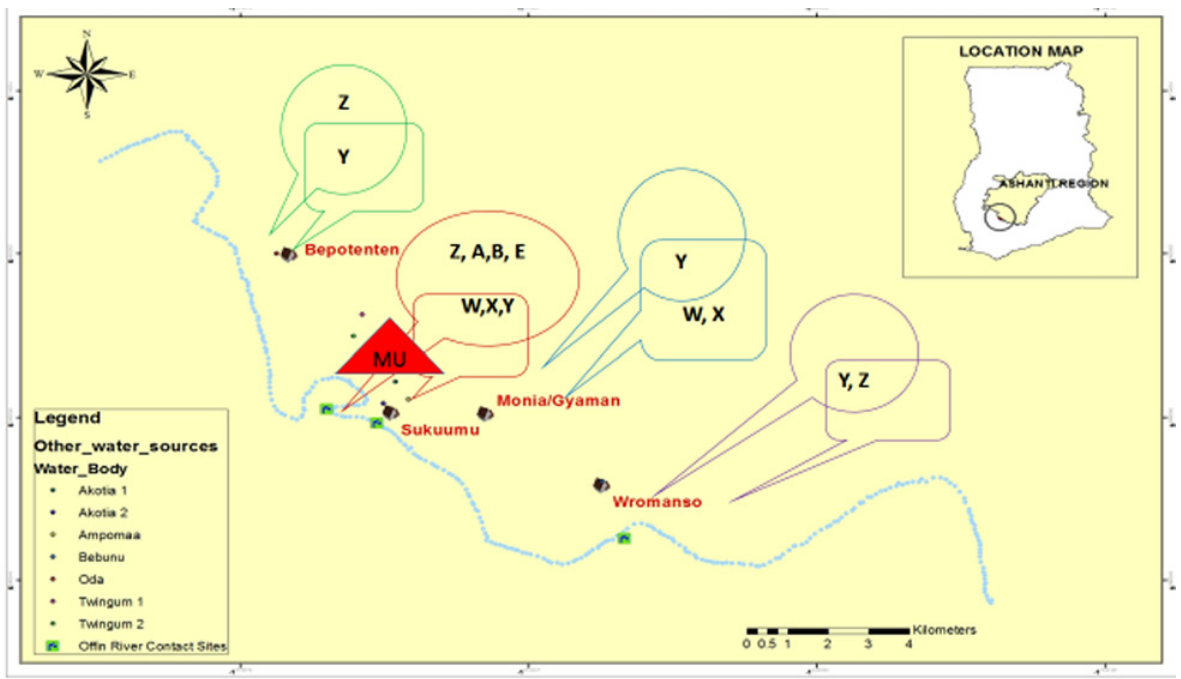
Figure 4. Community-based geographical distribution of MPM genotypes from humans and water bodies. The map of study communities was drawn using ArcMap 10. Rectangular and circular callouts contain genotypes of MU detected in humans and the environment respectively. Intersection of callouts contain genotypes common to both sources. Red triangle (in Sukuumu) represents MU-positive animal. Genotypes W, X, Y and Z were found both in the environment and human population. The Offin River is represented by blue dotted lines and contact sites on it are represented by green squares. Communities are represented by symbol for a house and other sampled water bodies are represented by colored dots as defined in the legend.